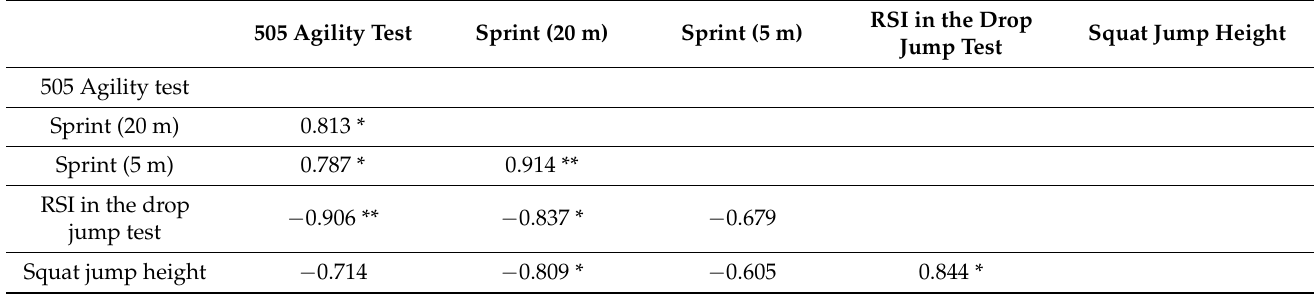
Table 3. Relationships between sprint and strength parameters in handball